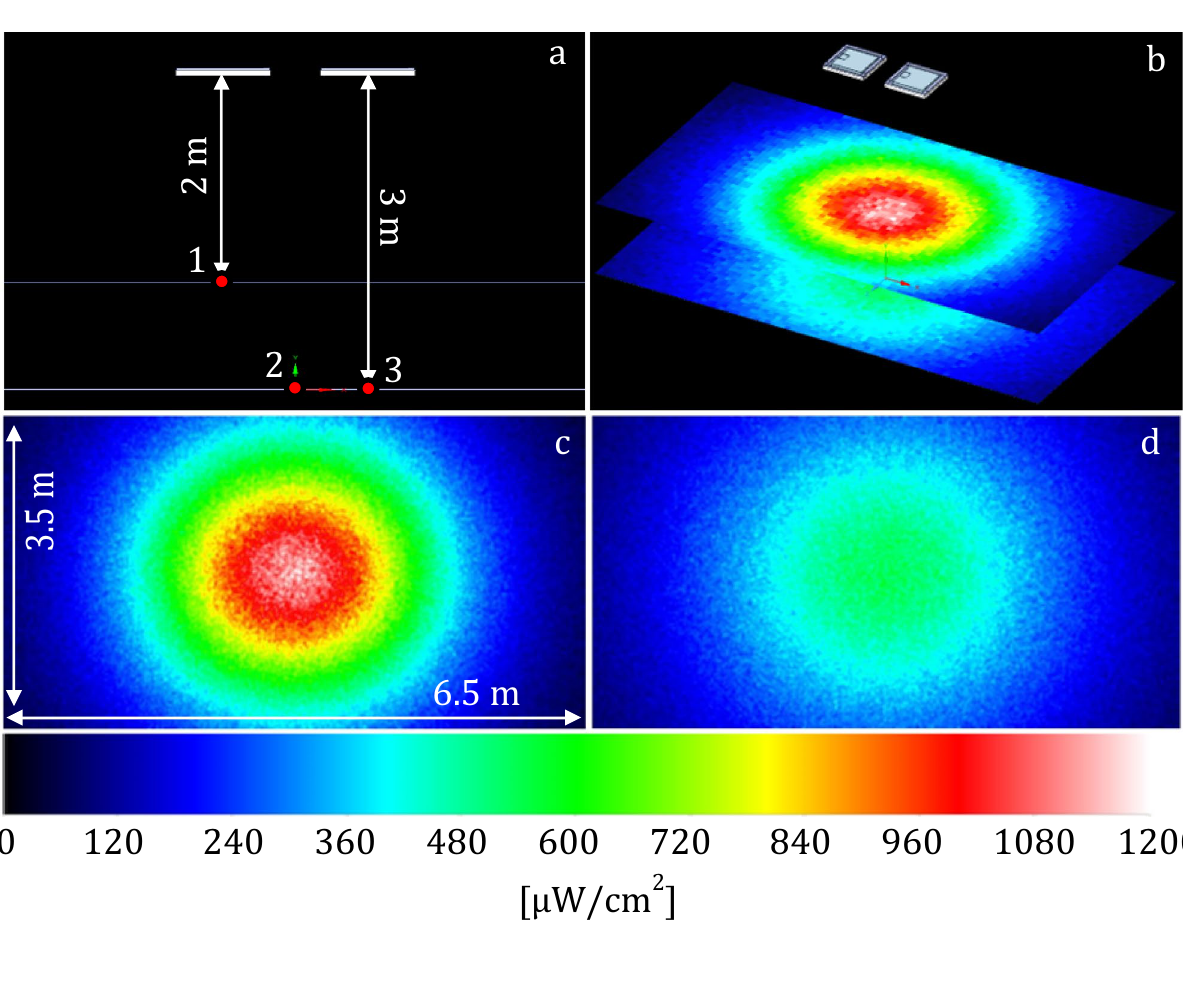
Figure 6. Ansys Speos simulator. ( a ) distance between the measurement and simulation planes and the ceiling where the lamps are located; ( b ) color representation of the irradiance distribution on the simulation planes; ( c ) distribution of irradiance on the first plane (2 m from ceiling); ( d ) distribution of irradiance on the second plane (3 m from ceiling).